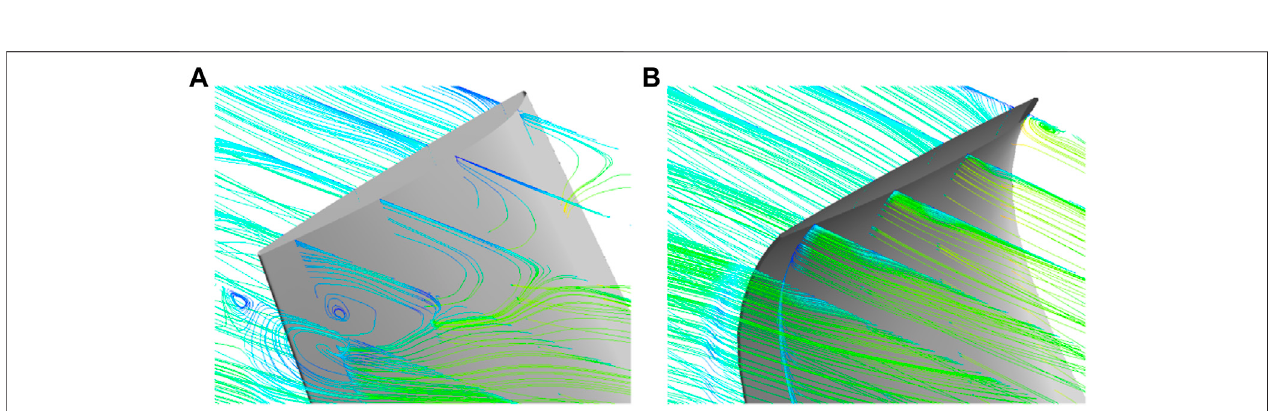
FIGURE 12 | Streamline at the root: (A) traditional blade and (B) forward-swept blade.